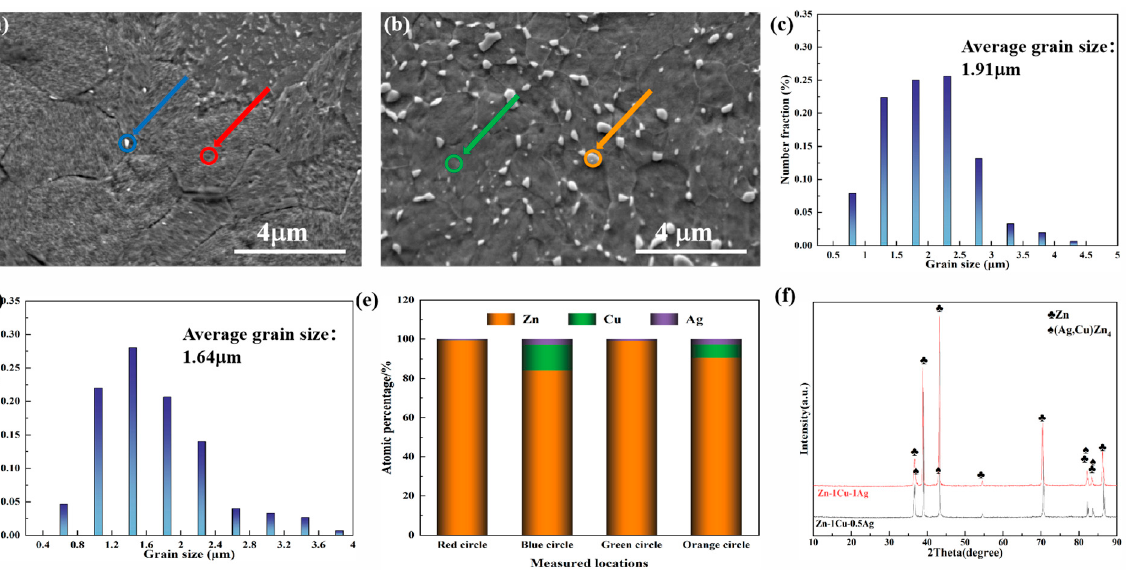
Figure 2. ( a , b ) The SEM micrographs; ( c , d ) grain size distribution, ( e ) EDS point analysis results taken from the hollow circles in ( a , b ); ( f ) XRD patterns of Zn-1Cu-0.5Ag, Zn-1Cu-1Ag components.